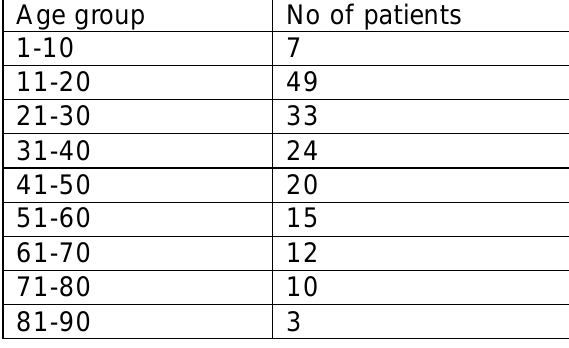
Table 1.Age distribution